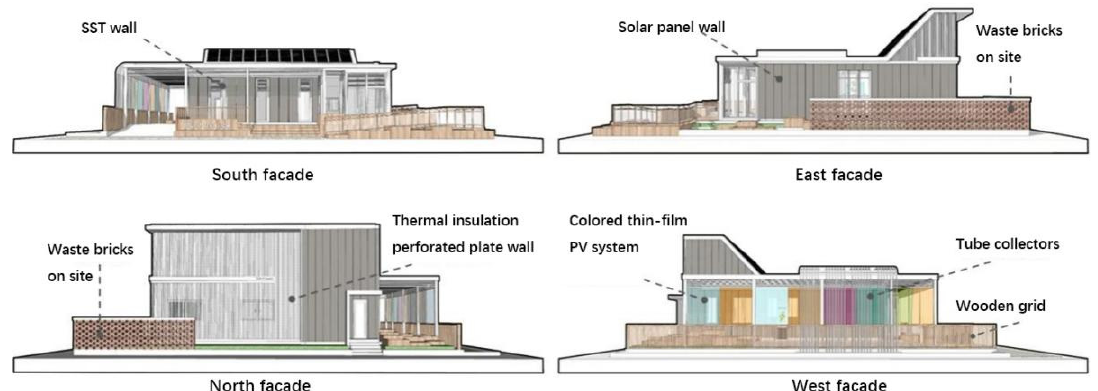
Figure 12. Facade design model.